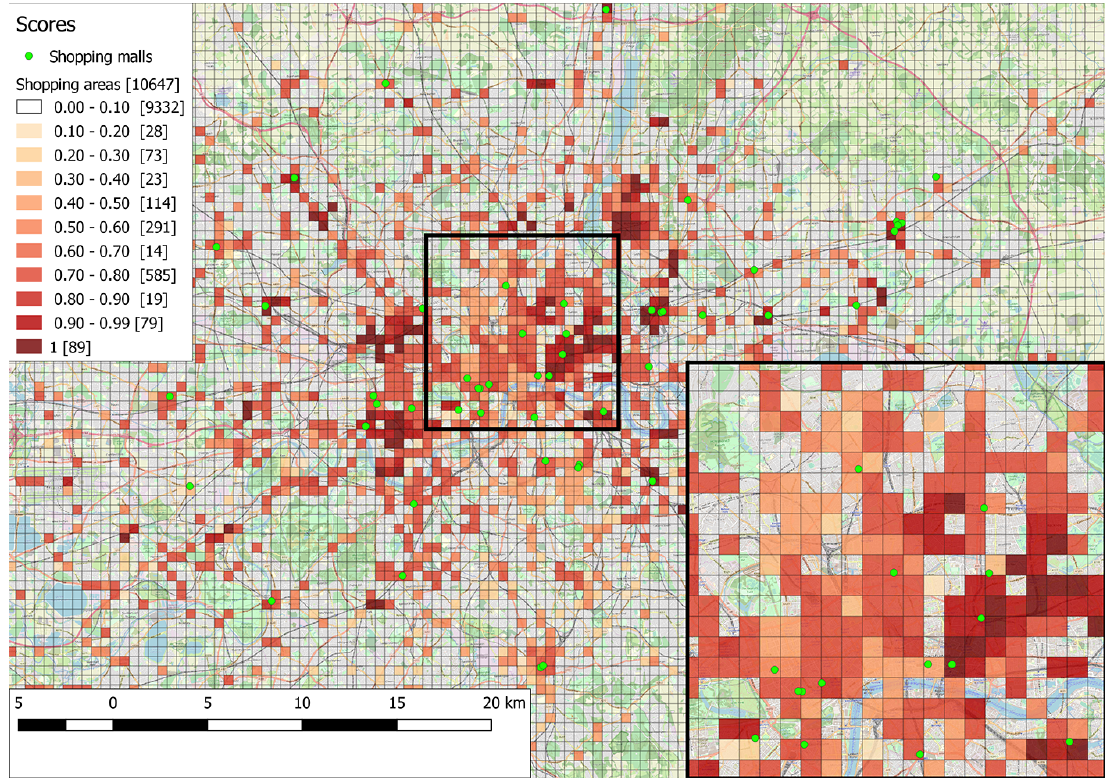
Figure 7. Results using probabilistic pattern with adjusted scores. Table 8. Scores and population